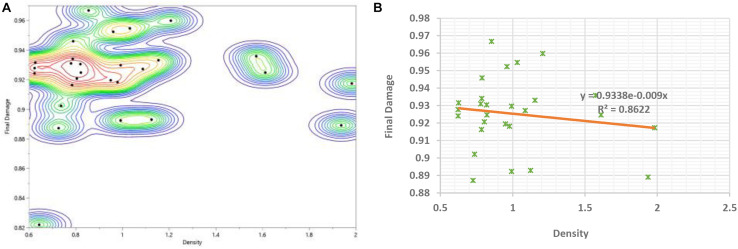
(A) Bivariate fit of final damage by density (B) Final damage versus density showing the exponential fit with the analytical equation.